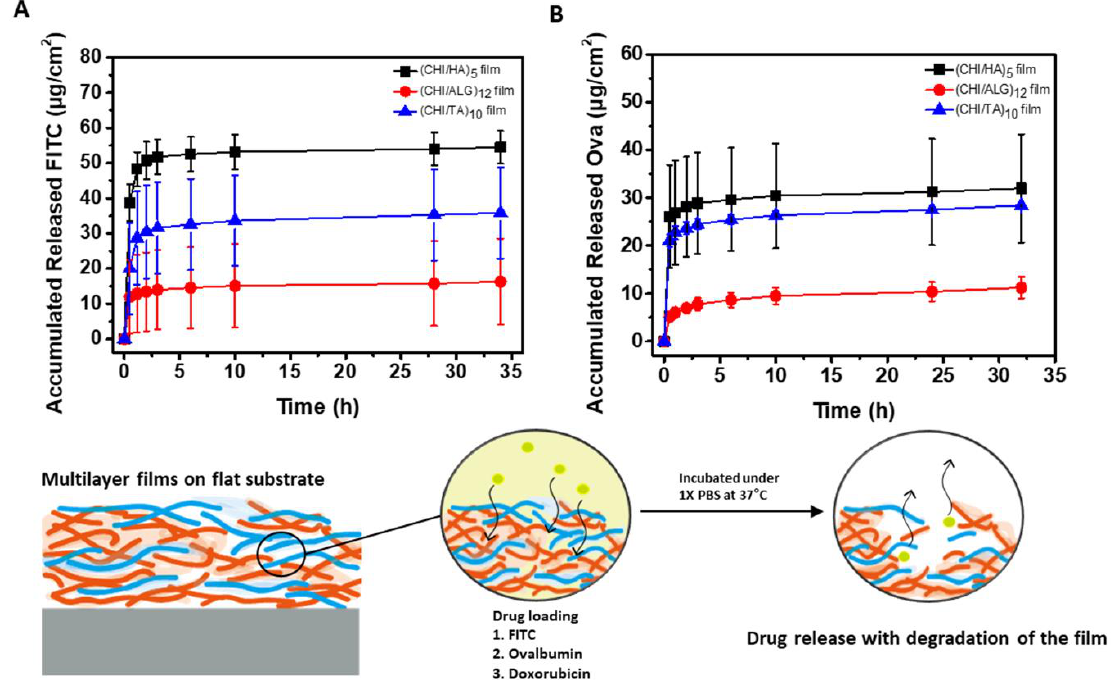
Figure 6. Accumulated amount of released ( A ) FITC and ( B ) Ova from multilayer films under 1× PBS at 37 °C.